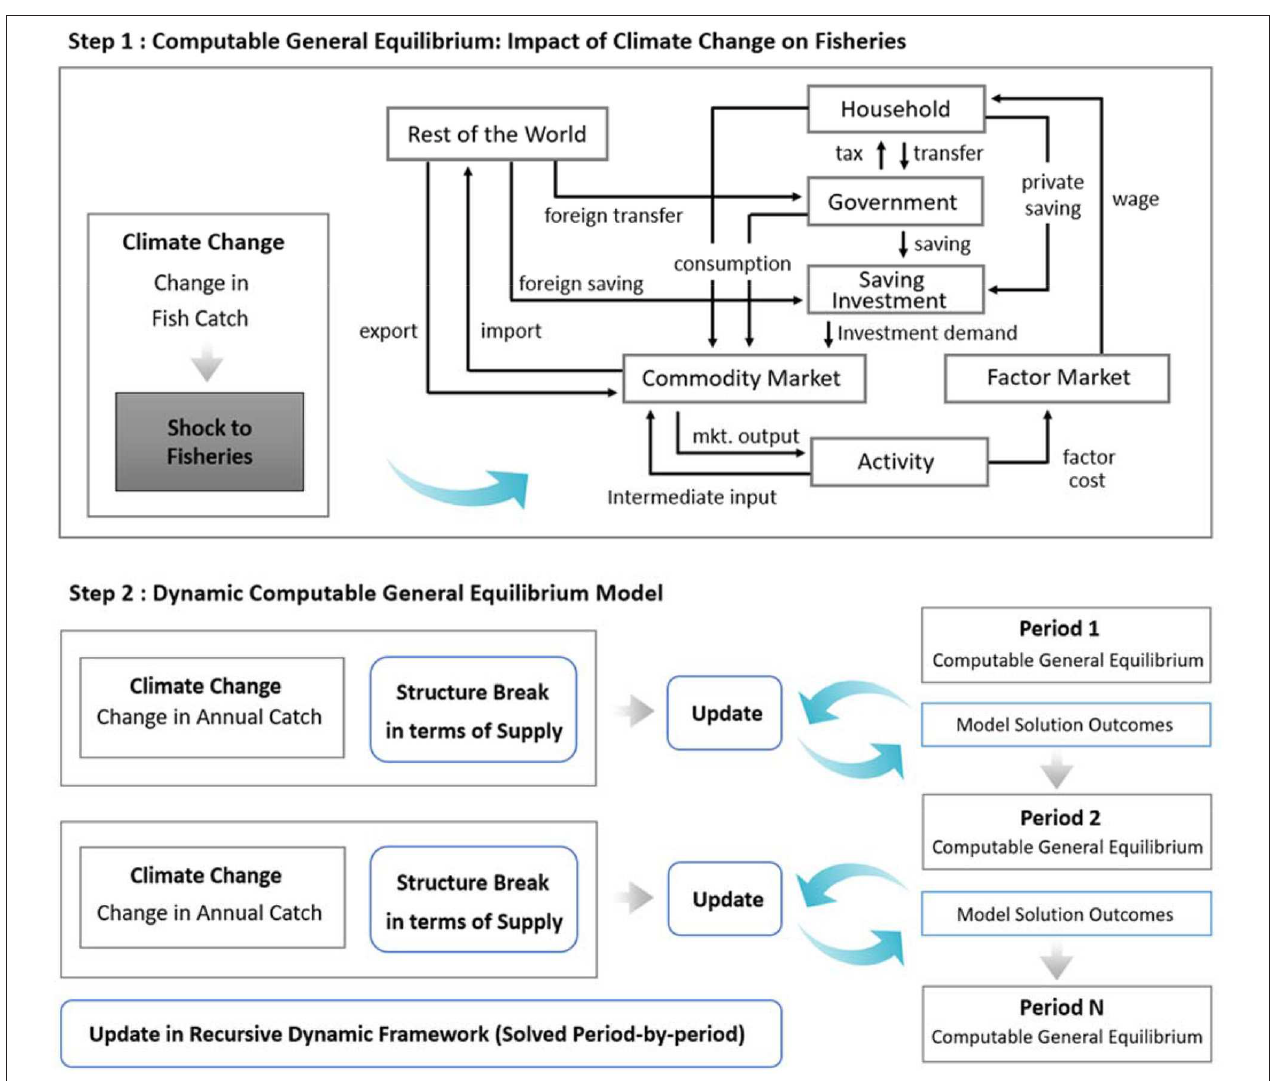
FIGURE 1 | Conceptual framework of CGE for impact of change on